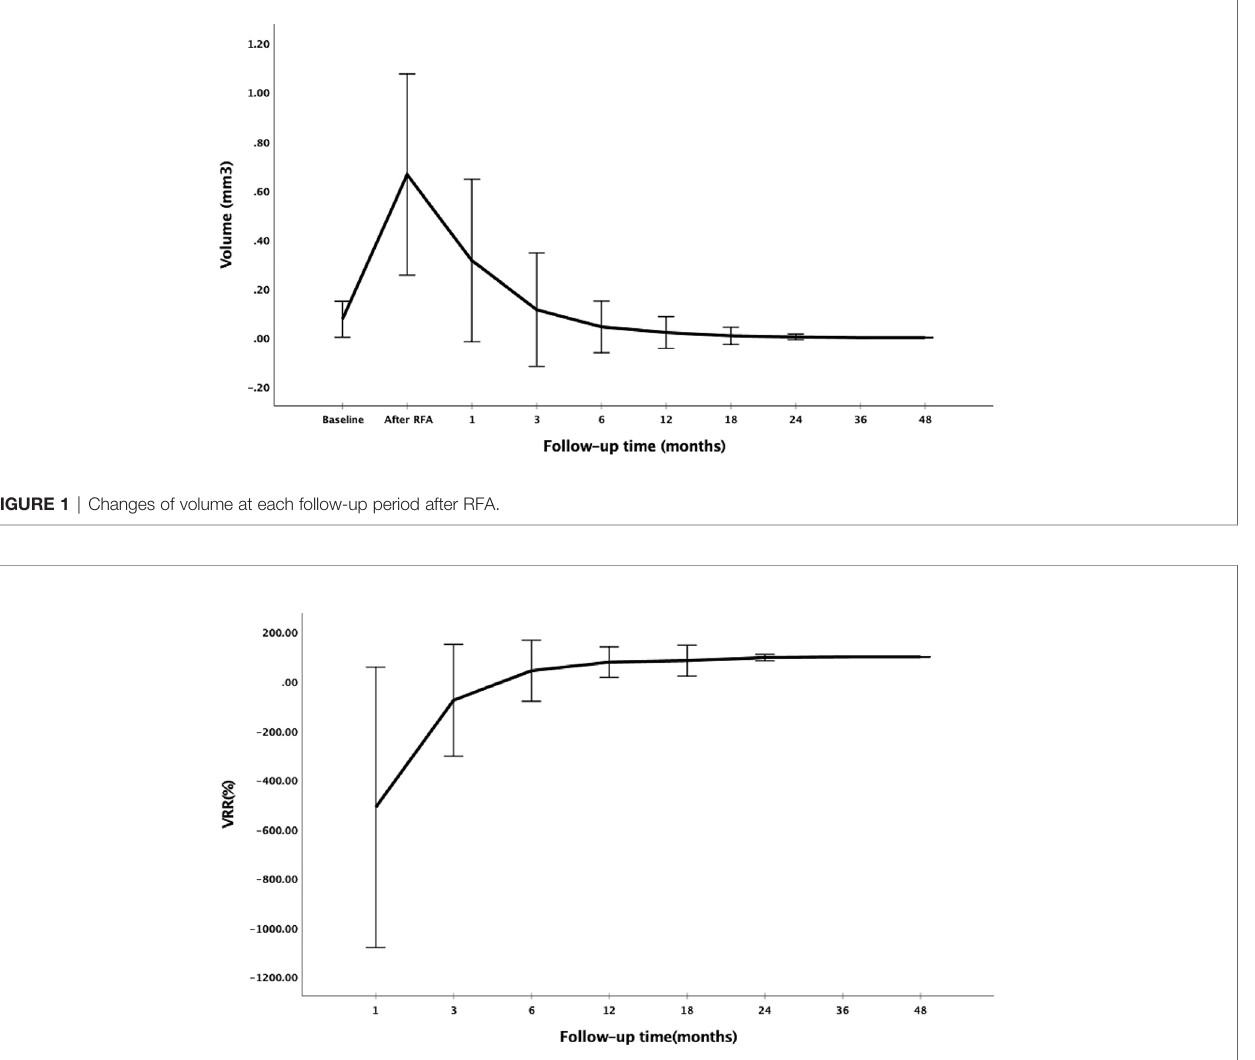
FIGURE 2 | Changes of VRR at each follow-up period after